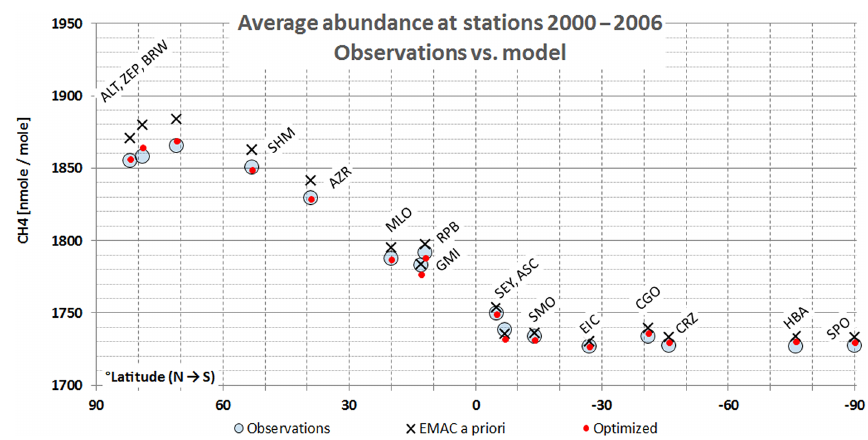
Figure 3. Optimization of calculated ground station CH 4 mixing ratios towards observations (blue circles): a priori simulations (black crosses) – a posteriori simulations (red